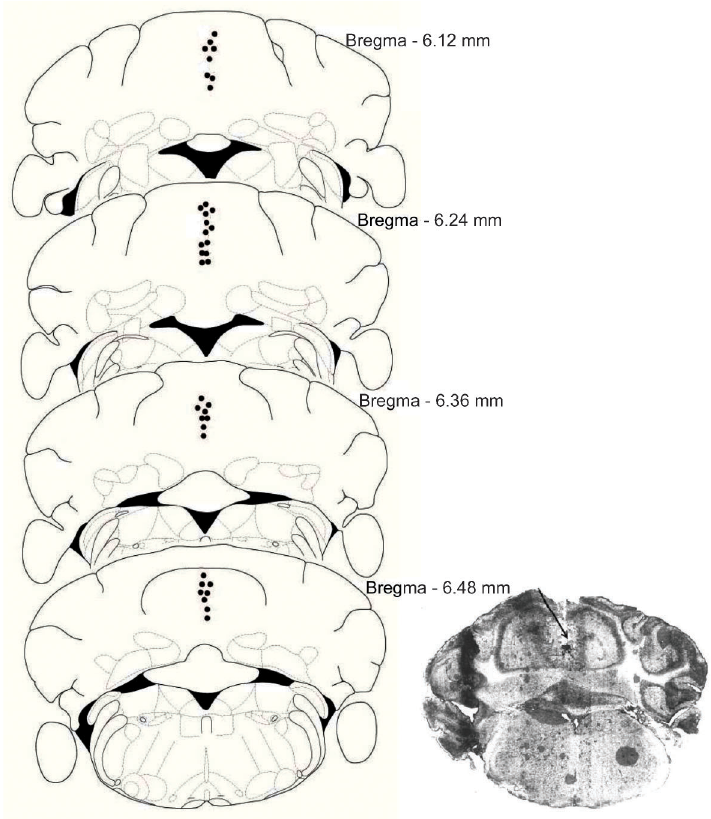
Figure 1. A , Schematic representation (adapted from Ref. 22) of sites of microinfusion (filled circles) into the cerebellum of mice. B , Photomicrograph showing a typical injection site (indicated by an arrow) in the cerebellar